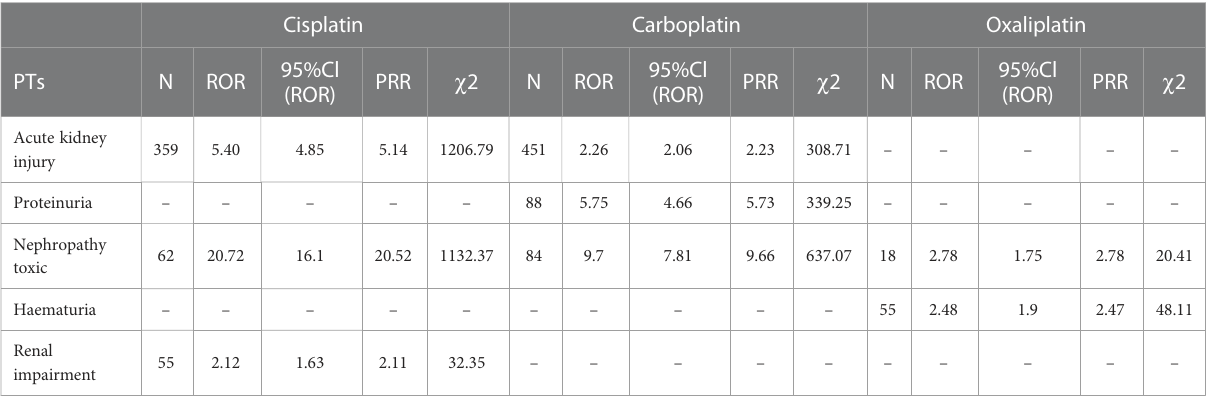
TABLE 3 Kidney and urinary system disorder-related adverse events of Cisplatin, Carboplatin and Oxaliplatin.